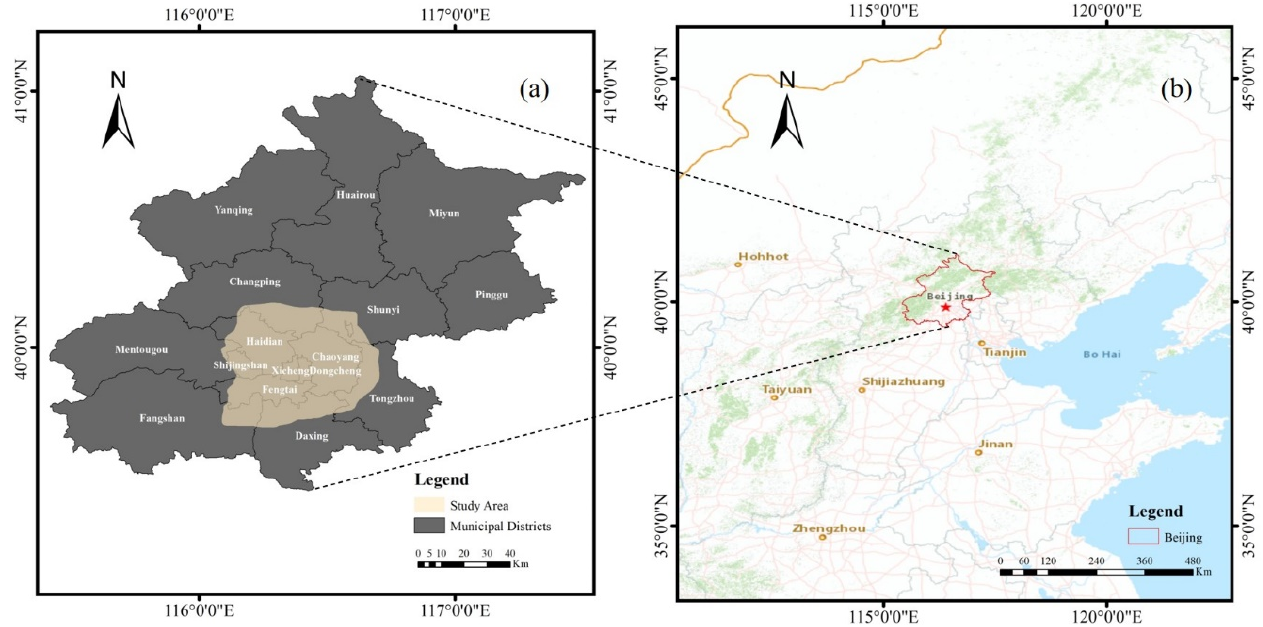
Figure 1. ( a ) Location of the study area and the municipal districts of Beijing. ( b )The location of Beijing in China. The base map is from ChinaOnlineCommunityENG (MapServer).